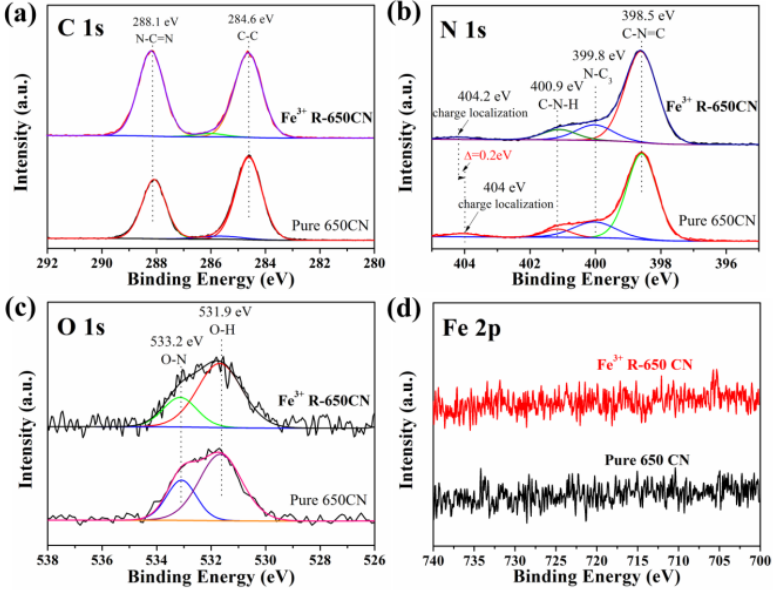
Figure 4. XPS spectra of samples pure 650 CN and Fe 3+ R-650 CN. ( a ) C 1s. ( b ) N 1s. ( c ) O 1s. ( d ) Fe 2p. Reprinted with permission from Ref. [49] . Copyright 2019 John Wiley and